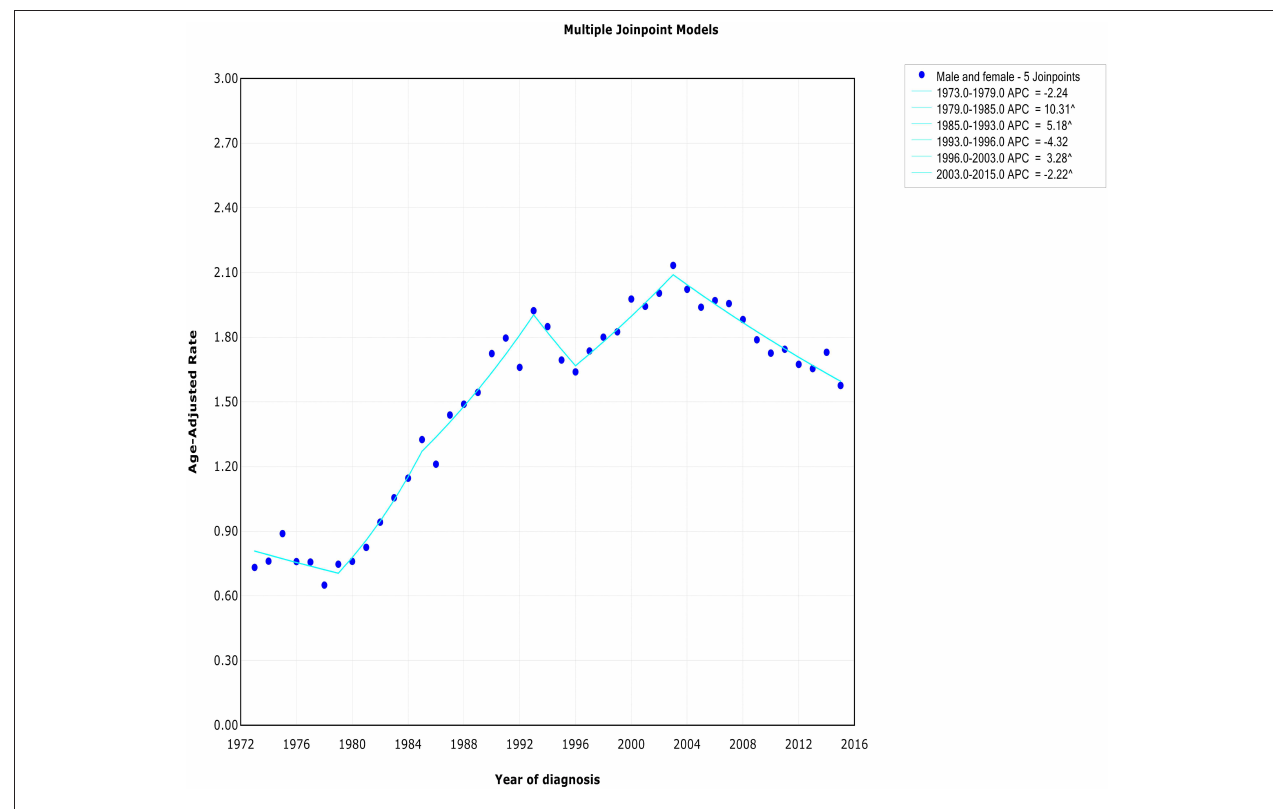
FIGURE 1 | The overall trends of incidence of extranodal DLBCL.